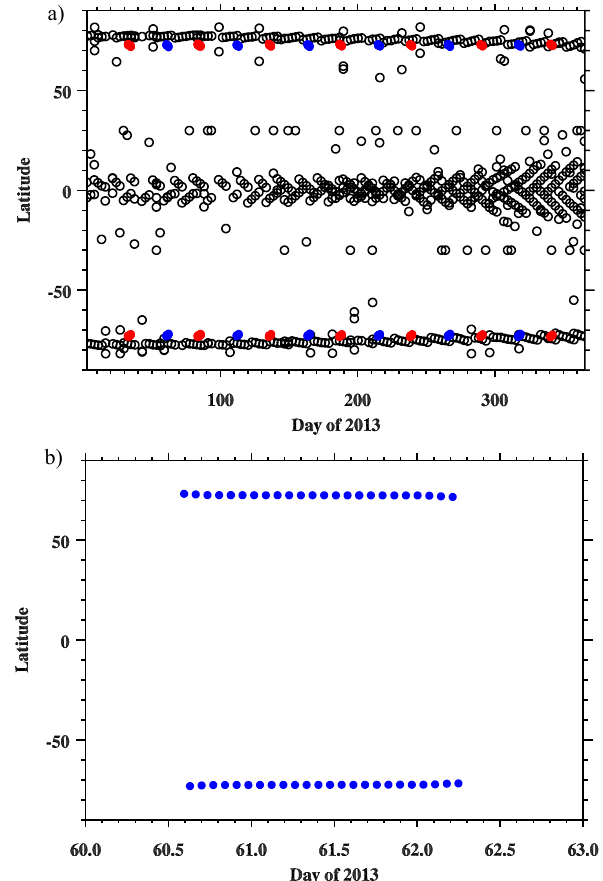
Figure 2. (a) Time series of latitude distribution of SNO events of CrIS–AIRS (black), CrIS–IASI/A(red), and CrIS–IASI/B (blue), and (b) enlarged plot for the SNO event of CrIS–IASI/B on 1–3 March